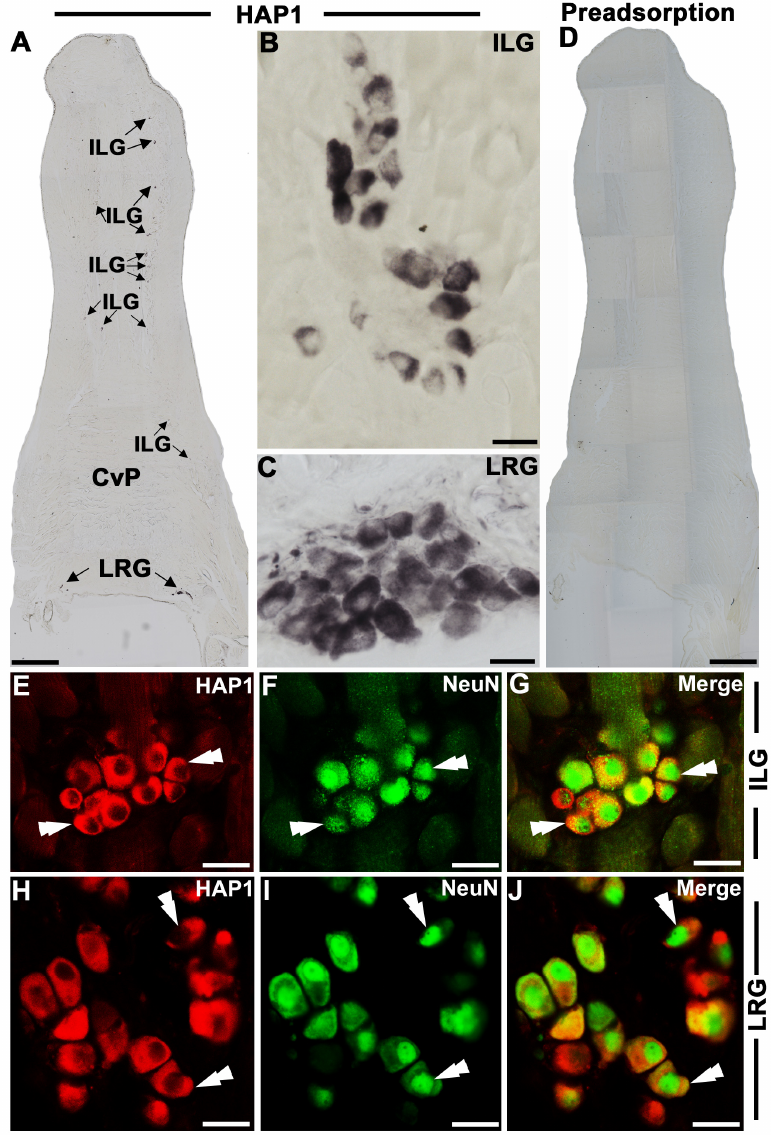
Figure 1. Immunohistochemistry for huntingtin-associated protein 1 (HAP1) in the lingual ganglia of the adult mouse. ( A ) Immunoperoxidase staining shows HAP1 immunoreactivity in the ILG and LRG. ( B , C ) enlargement of ILG and LRG indicating diffuse cytoplasmic HAP1-ir cells. ( D ) Preadsorption test (preincubation of HAP1 antibody with a blocking peptide) abolished the HAP1 immunoreactivity both in ILG and LRG. ( E – J ) Double immunofluorescence staining of HAP1 and NeuN in ILG and LRG. Cells positive for both HAP1 and NeuN are indicated by double arrowheads. ILG, intralingual ganglion; LRG, lingual root ganglion; CvP, circumvallate papillae. Scale bar = 400 µ m in ( A , D ), 20 µ m in ( B , C ), and 25 µ m in ( E – J